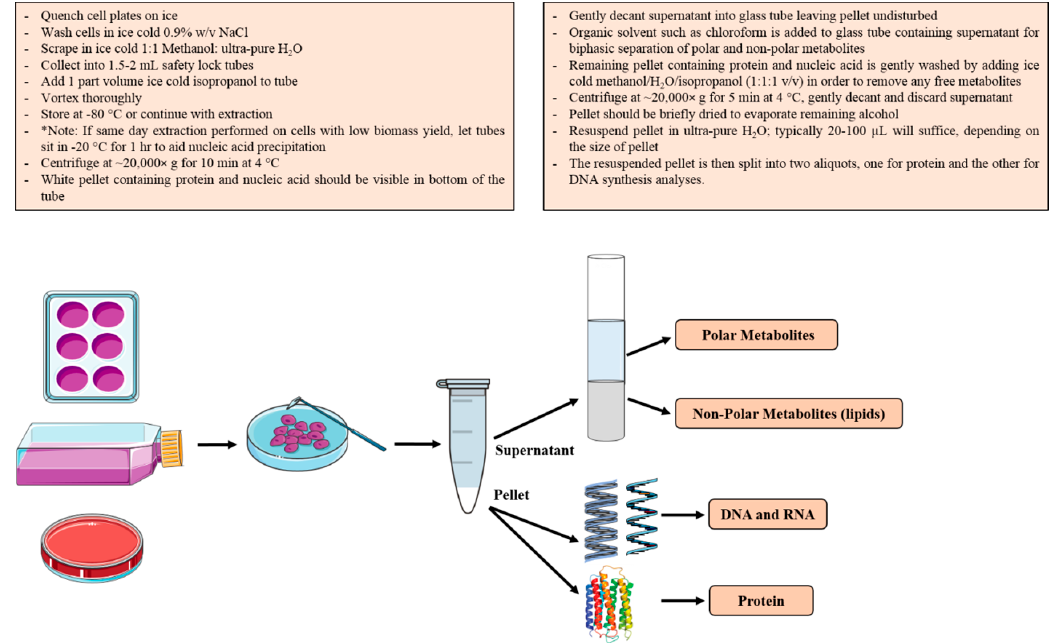
Figure 1. Schematic representation and general steps for the single sample biomass fractionation/extraction